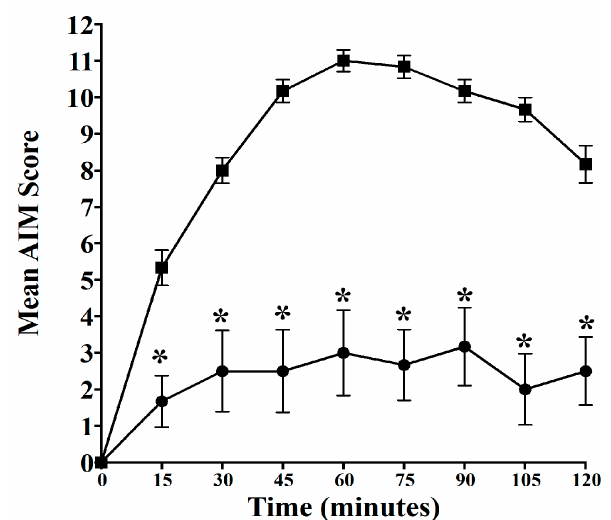
Figure 5. The Effect of Compound 6a on Abnormal Involuntary Movement (AIM) Scores in Hemi- parkinsonian Rats . Male hemiparkinsonian rats were purchased from Charles Rivers Laboratories. After a 21 daily intraperitoneal injection regimen of 8 mg/kg of L-dopa and benserazide (each) the animals were administered L-dopa/benserazide (8 mg/kg each) either with vehicle (10% DMSO in sterile water) or compound 6a at a dose of 10 mg/kg. Animals were scored on a scale from 0 to 4 for a) dystonic torsion of the trunk and neck contralateral to the lesion, b) dystonic movements of the forelimb contralateral to the lesion, c) orolingual movements with protrusion of the tongue and d) increased locomotion activity. Average AIM scores ± S.E.M. is shown for n = 6 animals in the presence (– • –) or absence (– (cid:4) –) of compound 6a . * A p < 0.05 value compared to vehicle control was observed for time points 15–120 min (one-way ANOVAs revealed main effects of Groups (F 1,10 ranging from 11 to 38.4 with p <